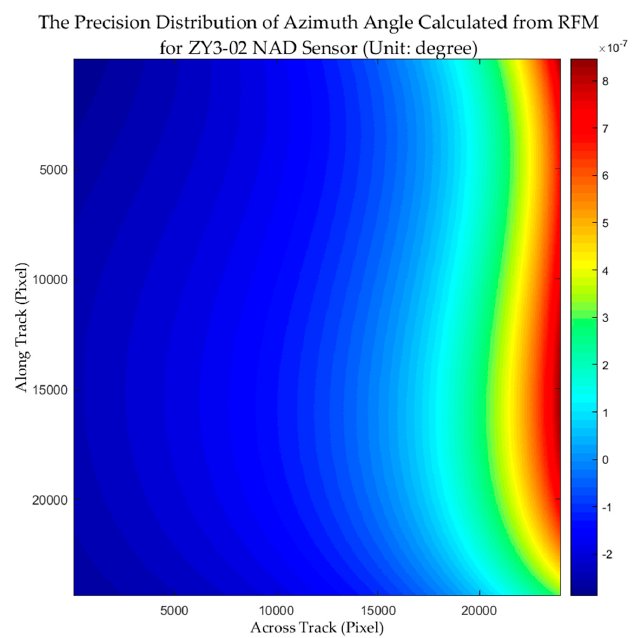
Figure 7. Precision distribution for the azimuth angle calculated from the Rational Function Model (RFM) for ZY3-02 panchromatic nadir (NAD) sensor (unit: degrees).